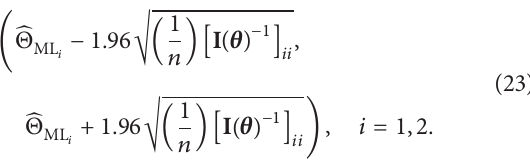
a large sample size we have Var [̂𝜅 ] → (1/𝑛)[ I ( 𝜃 ) −1 ] Var [̂𝜇 ML